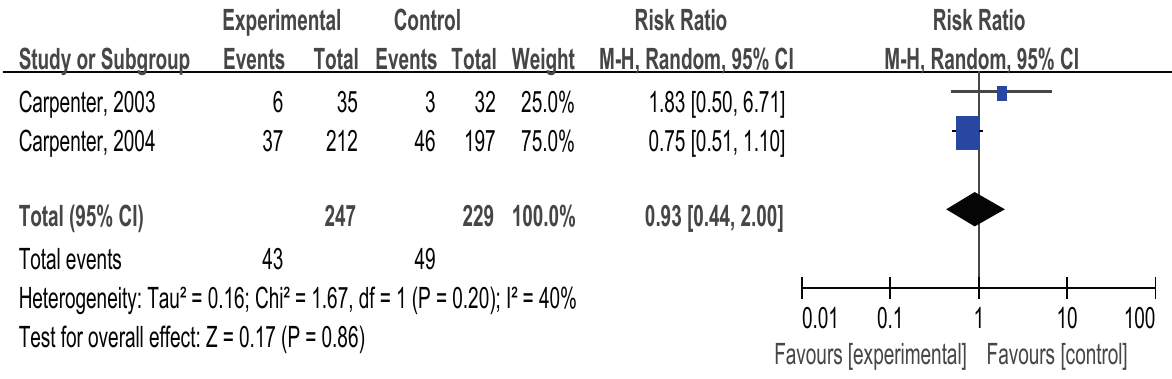
Figure 4. Forest plot of comparison: reduction support plus medication vs. other support plus